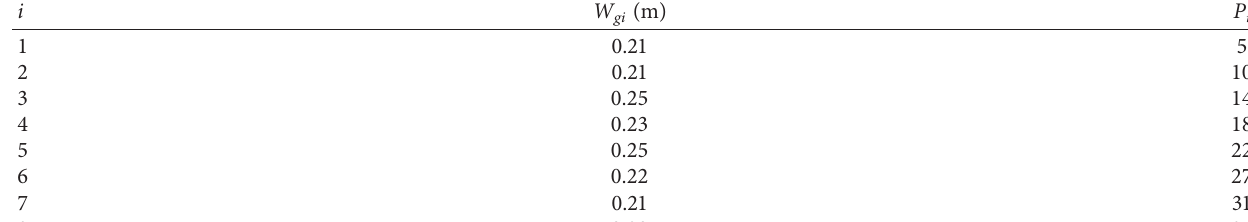
Table 9: Series of widths and locations of potholes II.